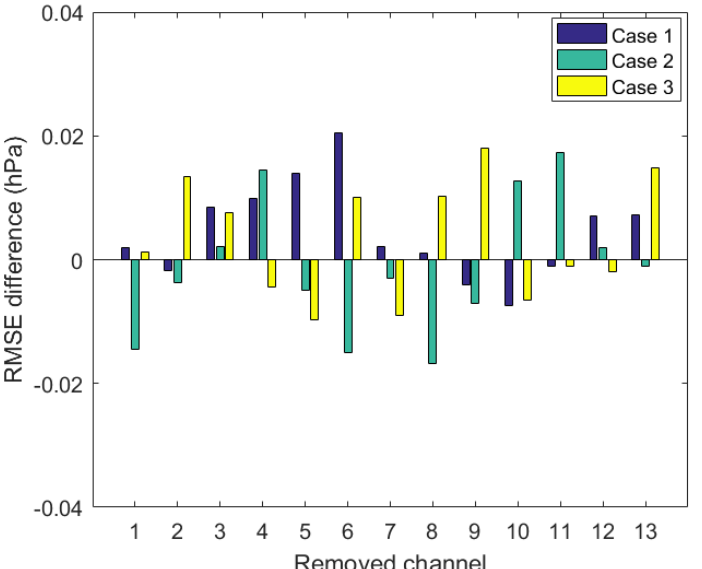
Figure 11. The stability test result of DNN in retrieving SSP using the observed brightness temperatures of the partial channel combinations.